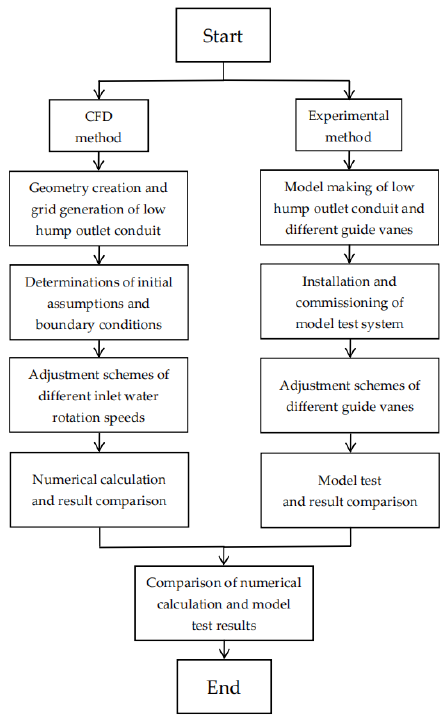
Figure 3. Flowchart of research methods.